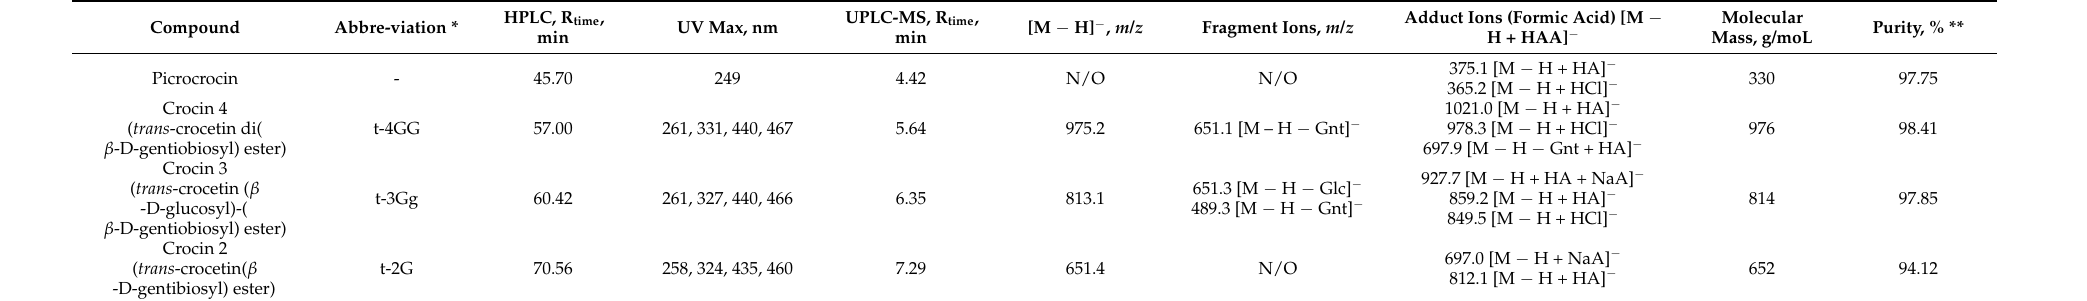
Table 3. Chromatographic and spectral data of pure components from